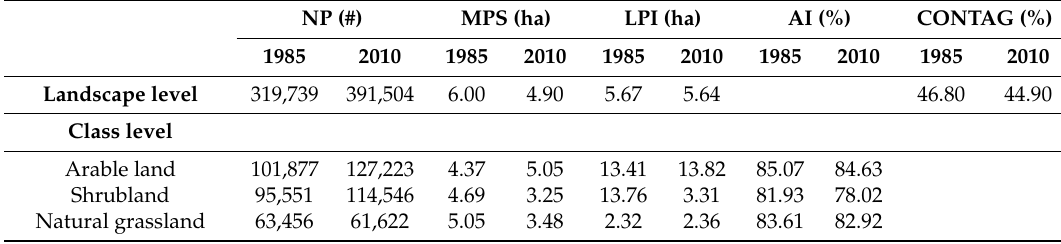
Table 6. Landscape metrics for selected LULC at the landscape and class levels, 1985–2010. NP (#) MPS (ha) LPI